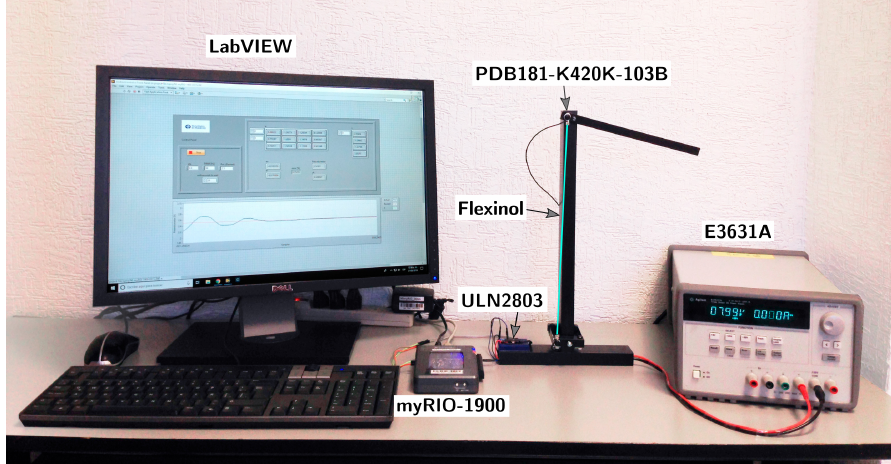
Figure 7. Photograph showing the experimental setup. The Flexinol wire has been marked in cyan.